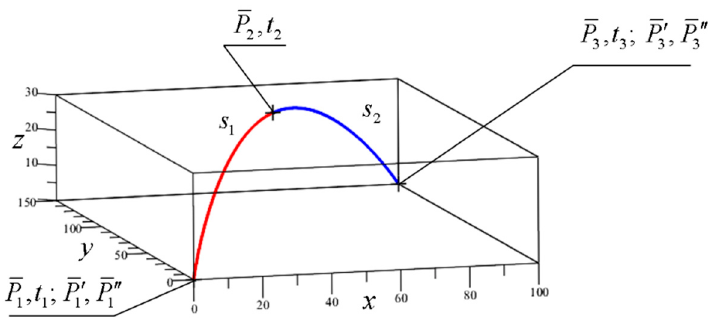
Figure 7. Calculated fifth-degree Hermite spline curve of two segments. Parameterization of the segments is fulfilled in range t 1 ≤ t ≤ t 2 for the segment s 1 and t 2 ≤ t ≤ t 3 for the segment s 2 . Without loss of generality, we accept that t 1 = 0 at the initial point of segment s 1 and t 2 = 0 at the initial point of segment s 2 . Let us express